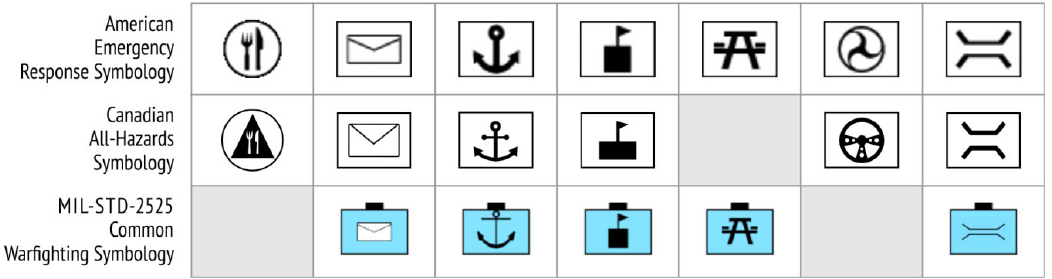
Figure 6. Selected examples of cartographic symbols that have been used in almost unchanged or very similar forms over a long period of time.